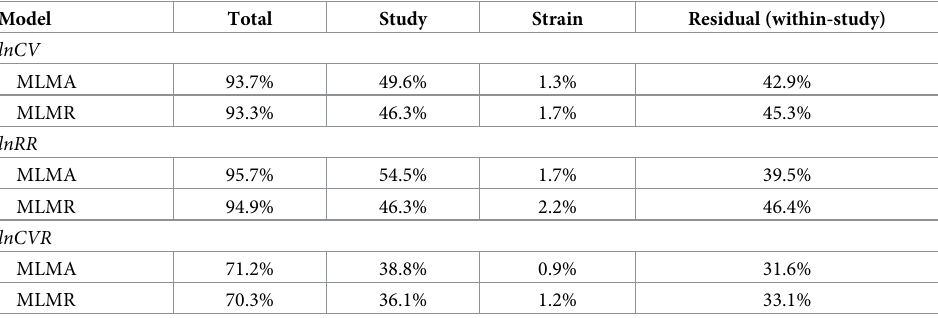
Table 1. Heterogeneity ( I 2 ) estimates for analyses of methodology on variability (lnCV) and drug treatment on mean (lnRR) and variance (lnCVR) in rat infarct volume. Model Total Study Strain Residual (within-study) lnCV MLMA 93.7% 49.6% 1.3% 42.9% MLMR 93.3% 46.3% 1.7% 45.3% lnRR MLMA 95.7% 54.5% 1.7% 39.5% 94.9% 46.3%